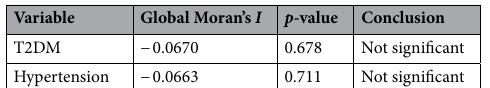
Table 3. Spatial cluster analysis using global Moran’s I test.